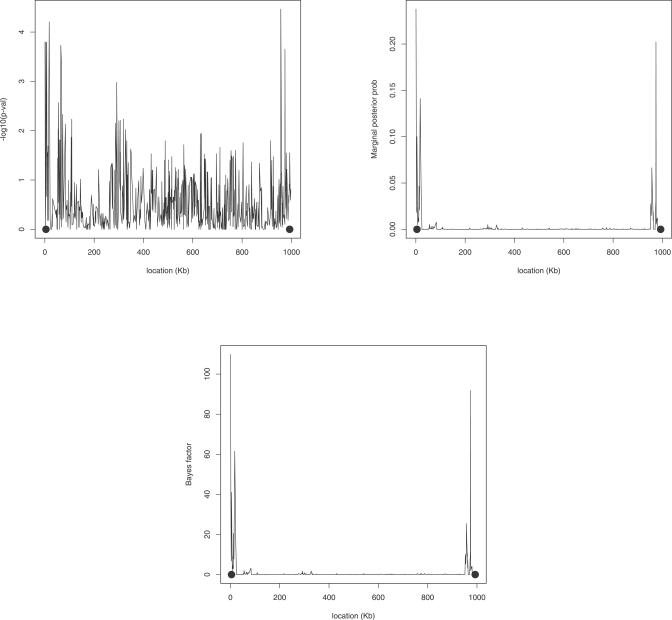
Results of Fisher's Exact Test and BETA from a Single Dataset with Two Susceptibility Alleles
p-Values from Fisher's exact test for single-marker disease association (top left), the marginal posterior probability of association from BETA (top right), and the Bayes factor in favour of association at each marker from BETA (bottom centre), where the dots on the x-axis indicate the positions of two susceptibility mutations.